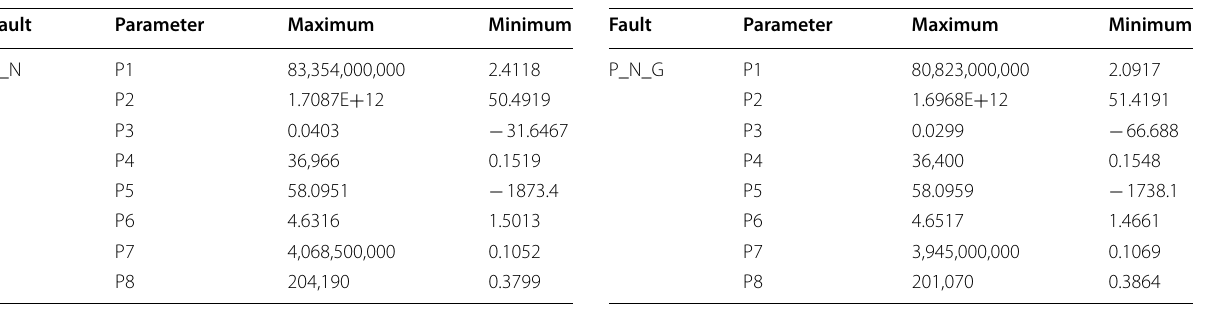
Table 3 PN short circuit fault ranges Table 4 PNG short circuit fault